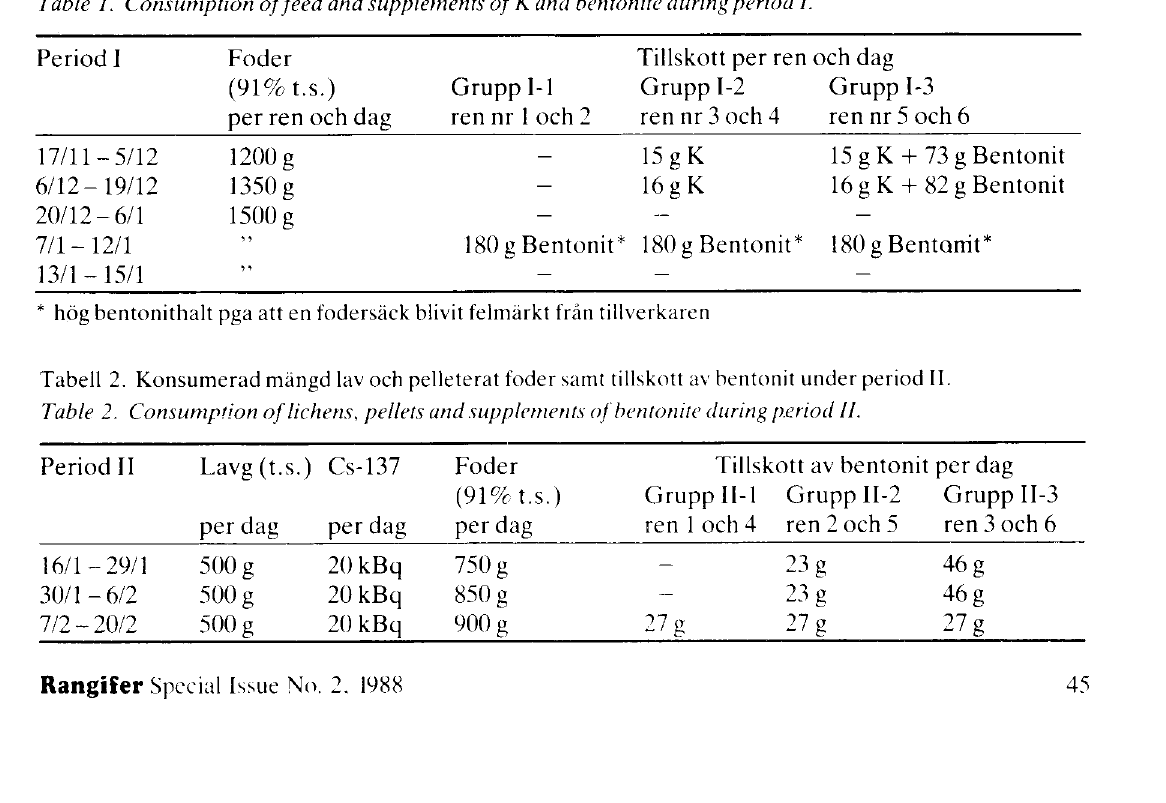
Table 2. Consumption of lichens, pellets and supplements of bentonite during period II. Period II Lavg